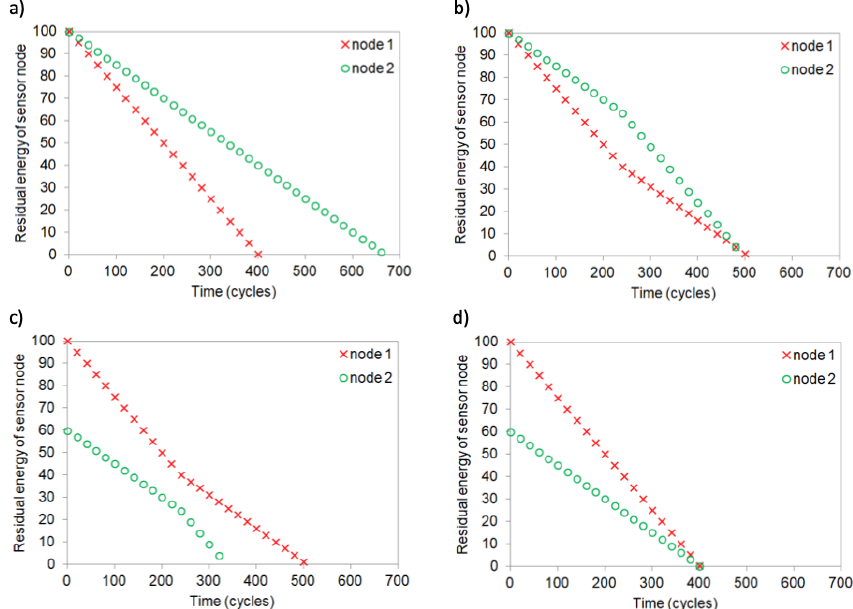
Figure 1. Changes of residual energy in WSN for different CH rotation scenarios: ( a ) the same initial energy levels without CH change, ( b ) the same initial energy levels with CH change, ( c ) different initial energy levels with CH change, ( d ) different initial energy levels without CH